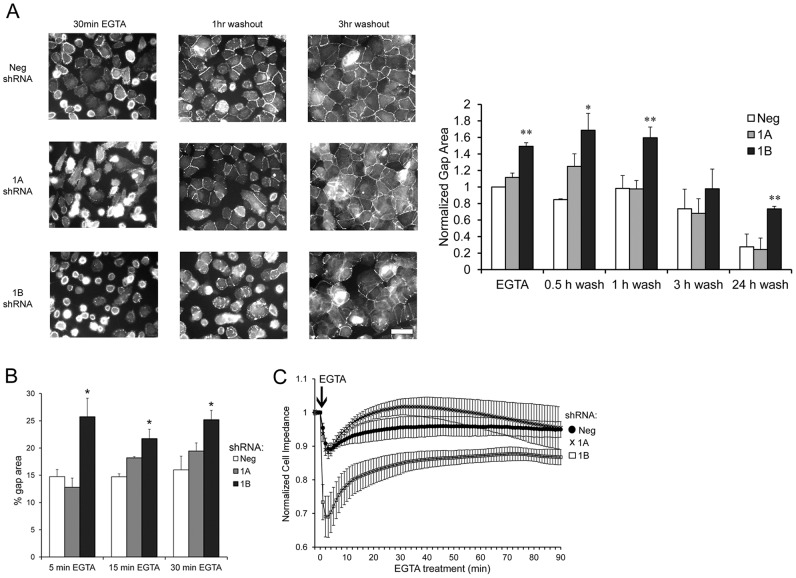
Rap1B knockdown in vitro affects dynamic junctional responses.Monolayer re-formation and resistance to EGTA-induced junctional disassembly were assessed using the calcium switch assay. (A) Representative immunofluorescence localization of ZO-1 after 30 min EGTA to disrupt junctions (left column), followed by 1 or 3 hr of washout to synchronously initiate junctional re-assembly (middle and right columns). Note greater cell-free areas (gaps) and impaired recruitment of ZO-1 to cell-cell contacts in Rap1B shRNA RPE. Quantification of the monolayer gap area per image field is shown in the graph. Recovery of Rap1B shRNA monolayer integrity was delayed compared to Neg control and Rap1A shRNA. (* compared to Neg, ** compared to Neg and Rap1A shRNA). Pooled averages (multiple random fields) from n = 3 independent experiments ± SEM, normalized to gap area of Neg control monolayers after EGTA treatment. *, **p≤0.05 (B) Gap area during EGTA-induced junctional disassembly was quantified as in panel A. EGTA treatment caused larger gaps in Rap1B shRNA monolayers compared with control or Rap1A shRNA monolayers. Graph shows the mean of n = 4 fields ± SEM, representative experiment from 2 independent trials. *p≤0.05, 1B shRNA compared to both Neg and 1A shRNA. (C) Electrical impedance analysis of cell monolayer disruption induced by EGTA. Data points represent the average ± SD from quadruplicate wells for each condition. Representative trace of 3 independent experiments.